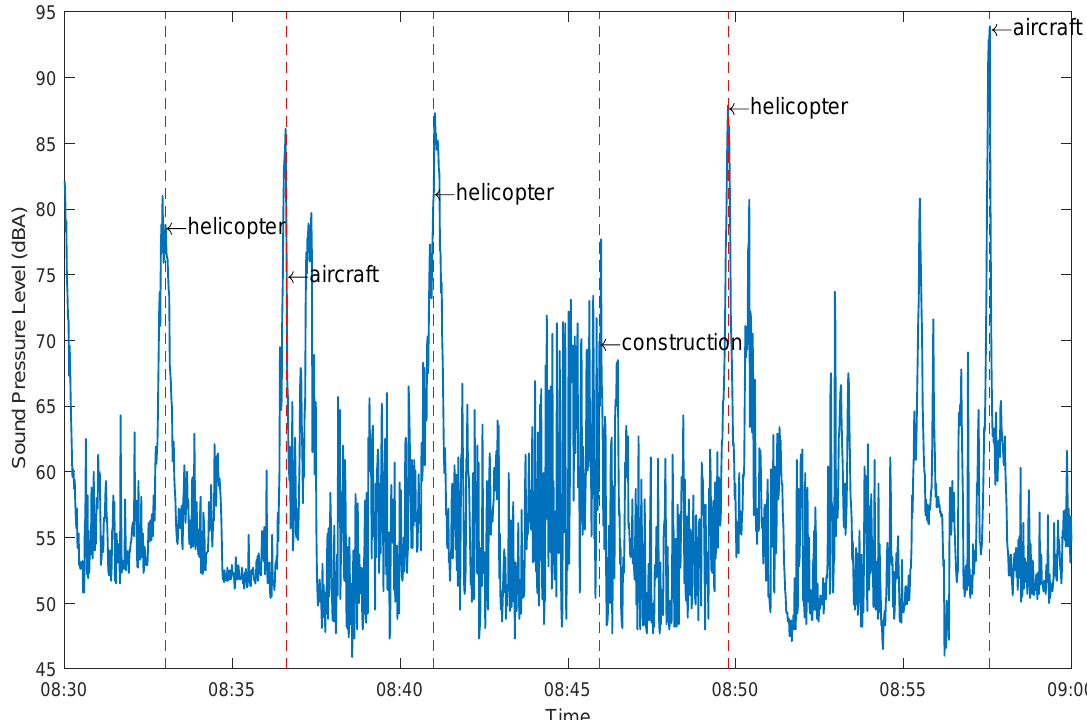
Figure 4: Characteristic sound pressure level variation for the morning period and non-scheduled noise events.